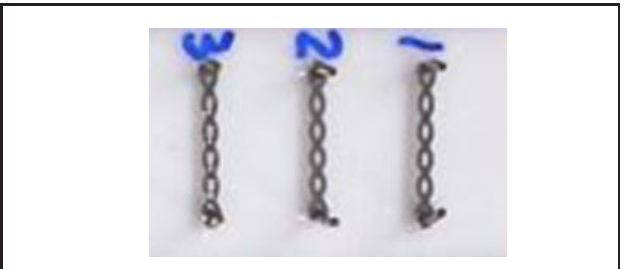
Fig. 1 - Test specimen (Plastic chain) stretched on plate.